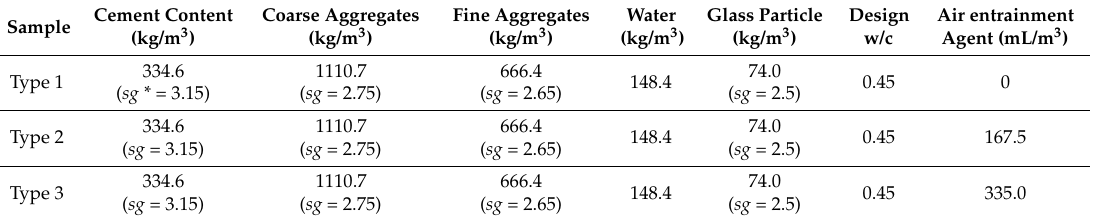
Table 1. Lab concrete mixture proportional design for early-age concrete studies. Cement Content Sample (kg/m 3